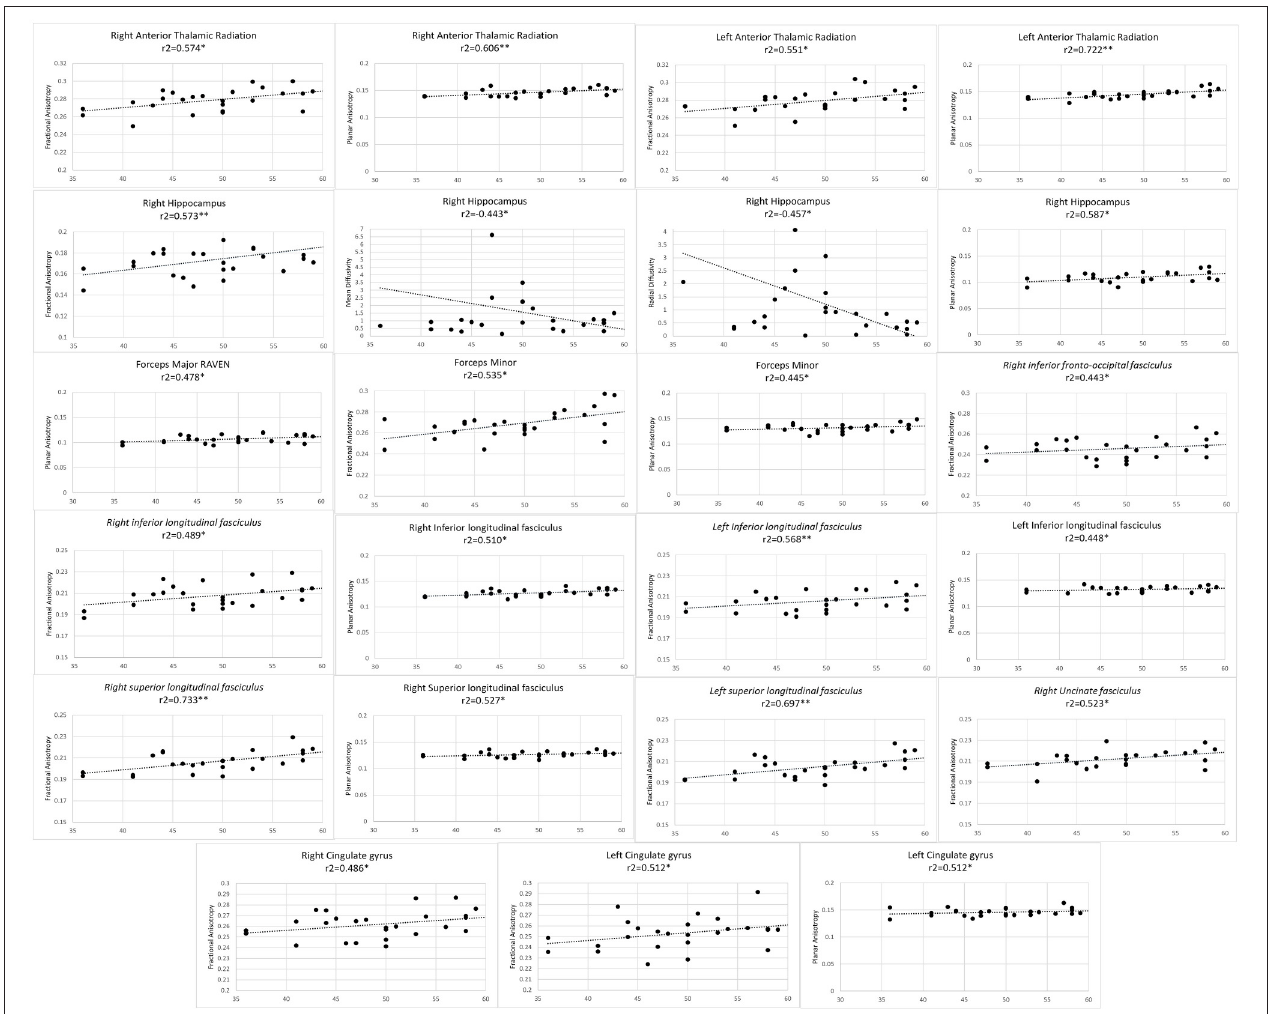
FIGURE 1 | Significant results from partial correlation analysis of diffusion metrics of Mori white matter atlas and chess players score in Raven’s progressive matrices